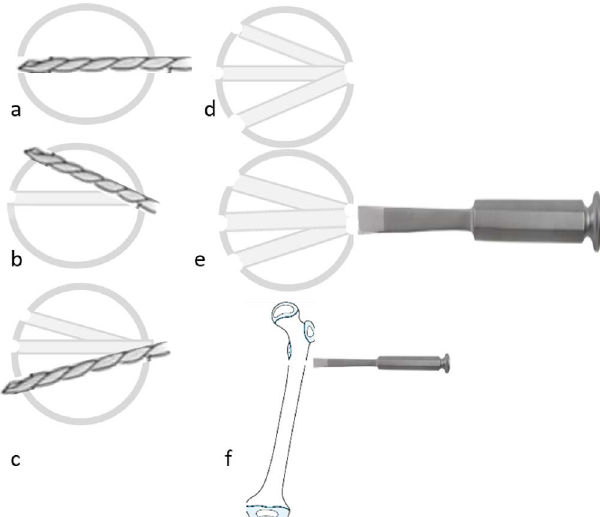
Figure 5. Percutaneous osteotomy: drilling the bone in different directions (a, b, c, d), then completing the osteotomy by osteotome (e,